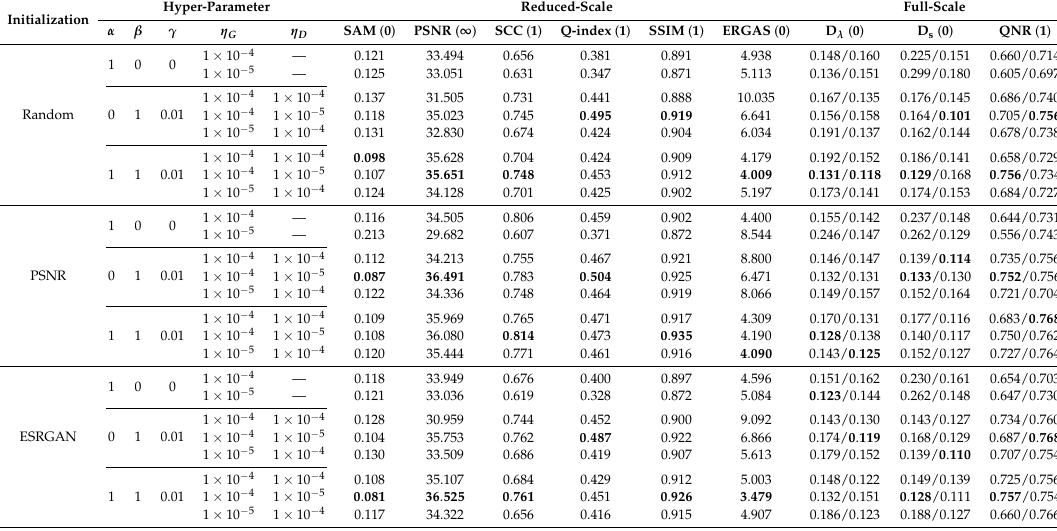
Table 5. Quality assessment of the proposed PercepPan under different settings on QuickBird dataset. “—” means the corresponding entry is invalid and the best value of each index is shown in